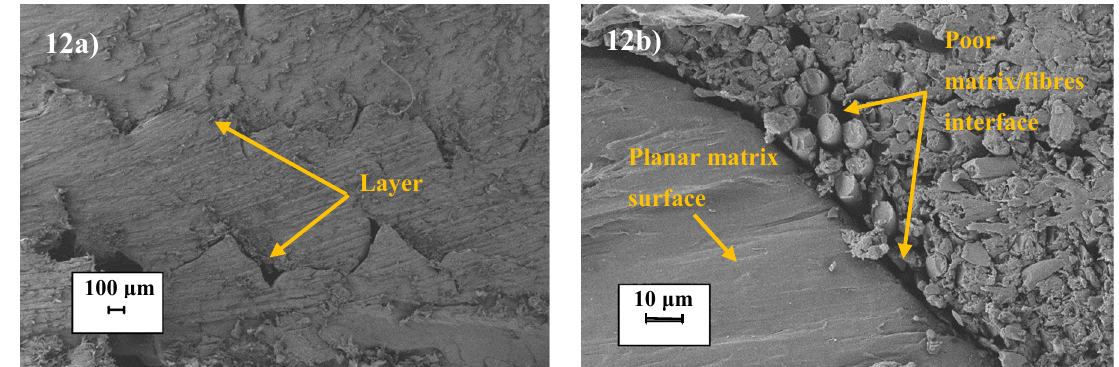
Figure 12. 1 K fibers sample before mechanical tests; ( a ) layer structure; ( b ) matrix/fibre interface.